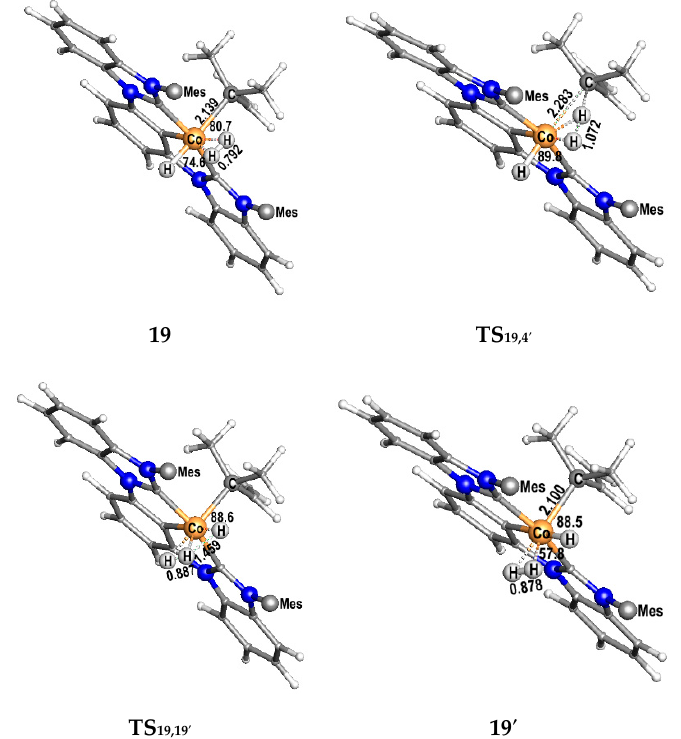
Figure 8. Optimized structures of 19 , TS 19,4 ′ (1150 i cm − 1 ), TS 19,19 ′ (129 i cm − 1 ), and 19 ′ . Mesitylene groups are omitted for clarity. Bond lengths are in Å, and bond angles are in °.